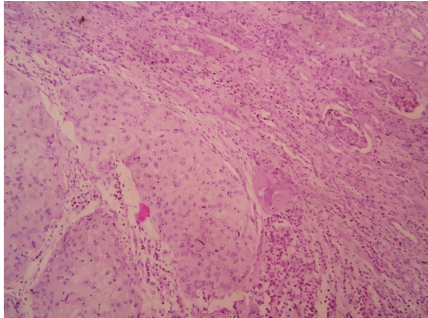
Figure 1: Presence of a hypodense renal mass of size approximately 6 × 8 cms in upper pole of right kidney with mild to moderate enhancement in nephritic phase.